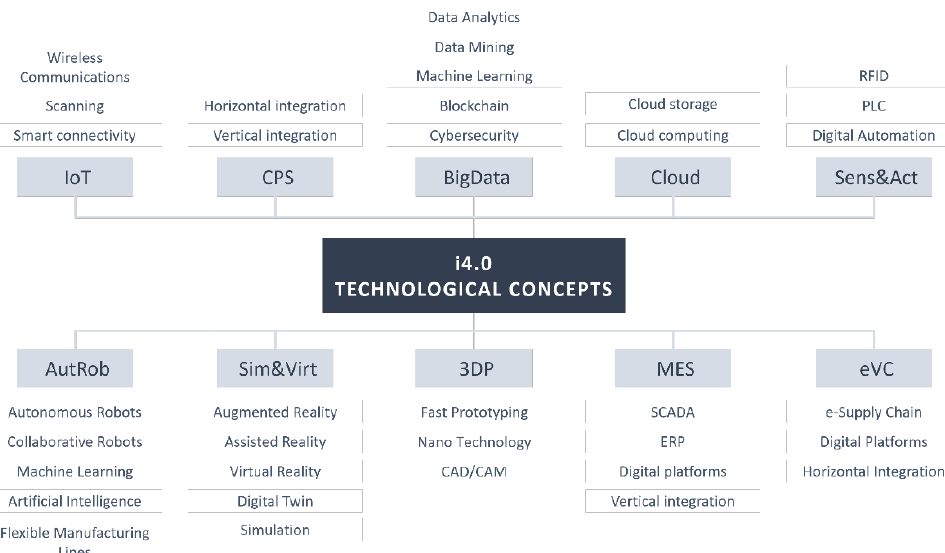
Figure 3. Coverage of each technological concept regarding other I4.0 concepts and technologies considered in this